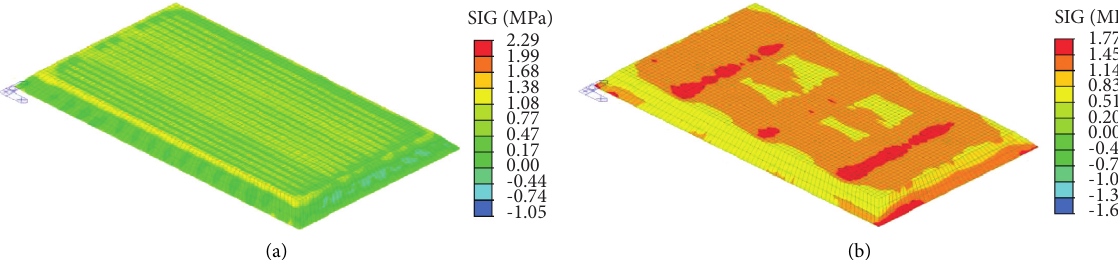
Figure 14: Cloud diagram of main tensile stress in the second layer of cap (unit: MPa). (a) Heating stage. (b) Cooling stage. Stress and allowable tensile strength